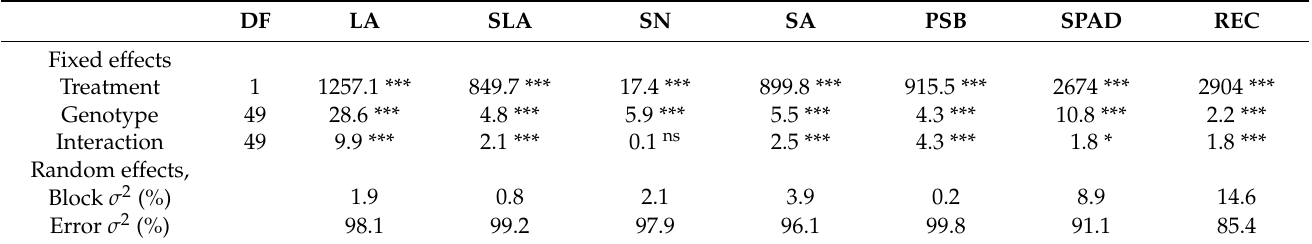
Table A3. Mixed-model ANOVA fixed-effects F-test statistics with significance levels and random effects variance components for treatment and genotype on morphological